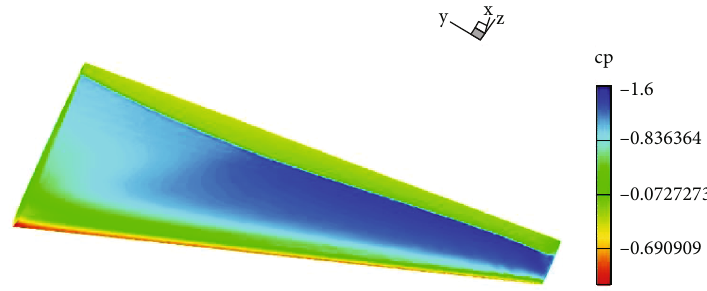
Figure 7: The pressure coe ffi cient (Cp) distribution map of lower